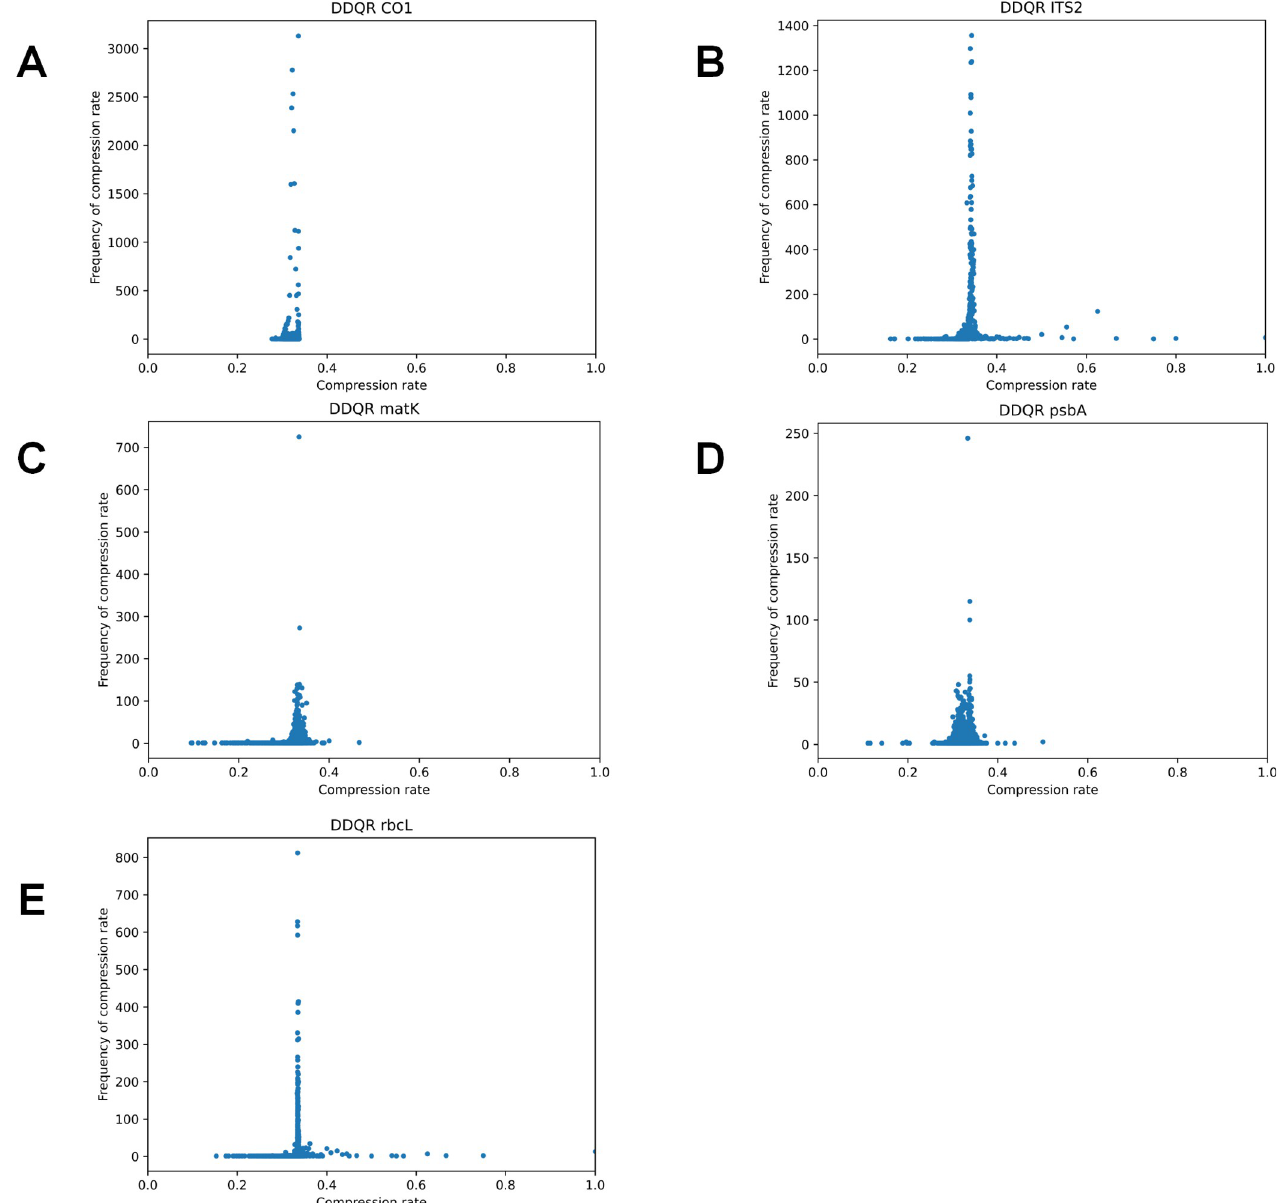
Fig 4. Compression rate of DDQR using real data. Five different DNA barcode marker datasets are used: ITS2 (A), rbcL(B), matK (C), psbA-trnH (D), and CO1(E). The X-axis is the compression rate. The Y-axis is the frequency of the corresponding rate.